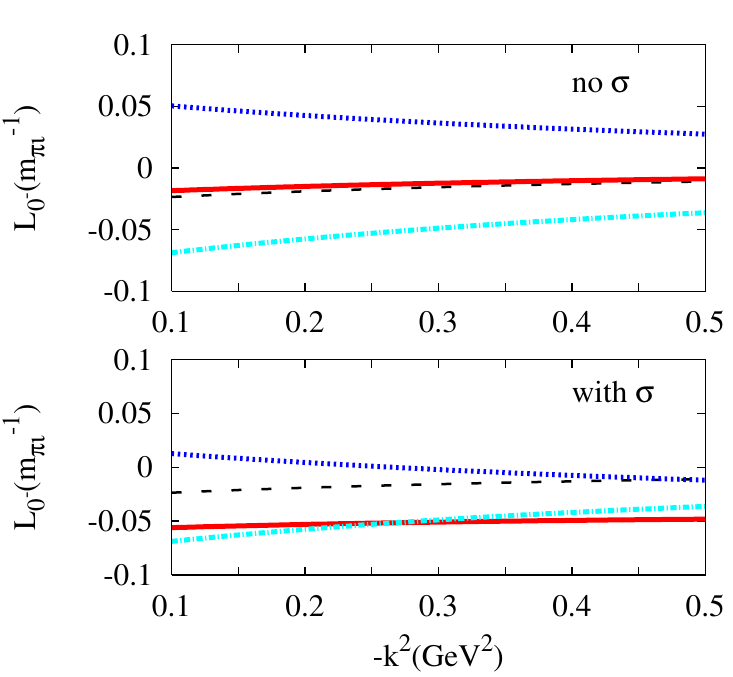
L ( + ) L ( − ) Fig. 2. (Color online) k 0 (upper) and k 0 (lower) amplitude in a unit m − 1 | k | | k | 0 + 0 + dashed (sky-blue) and dotted (blue) curve are contributions by Born and non-Born term, respectively. Solid (red) curves are final results by Eq.(16). Dashed (black) curves are results with µ = 0